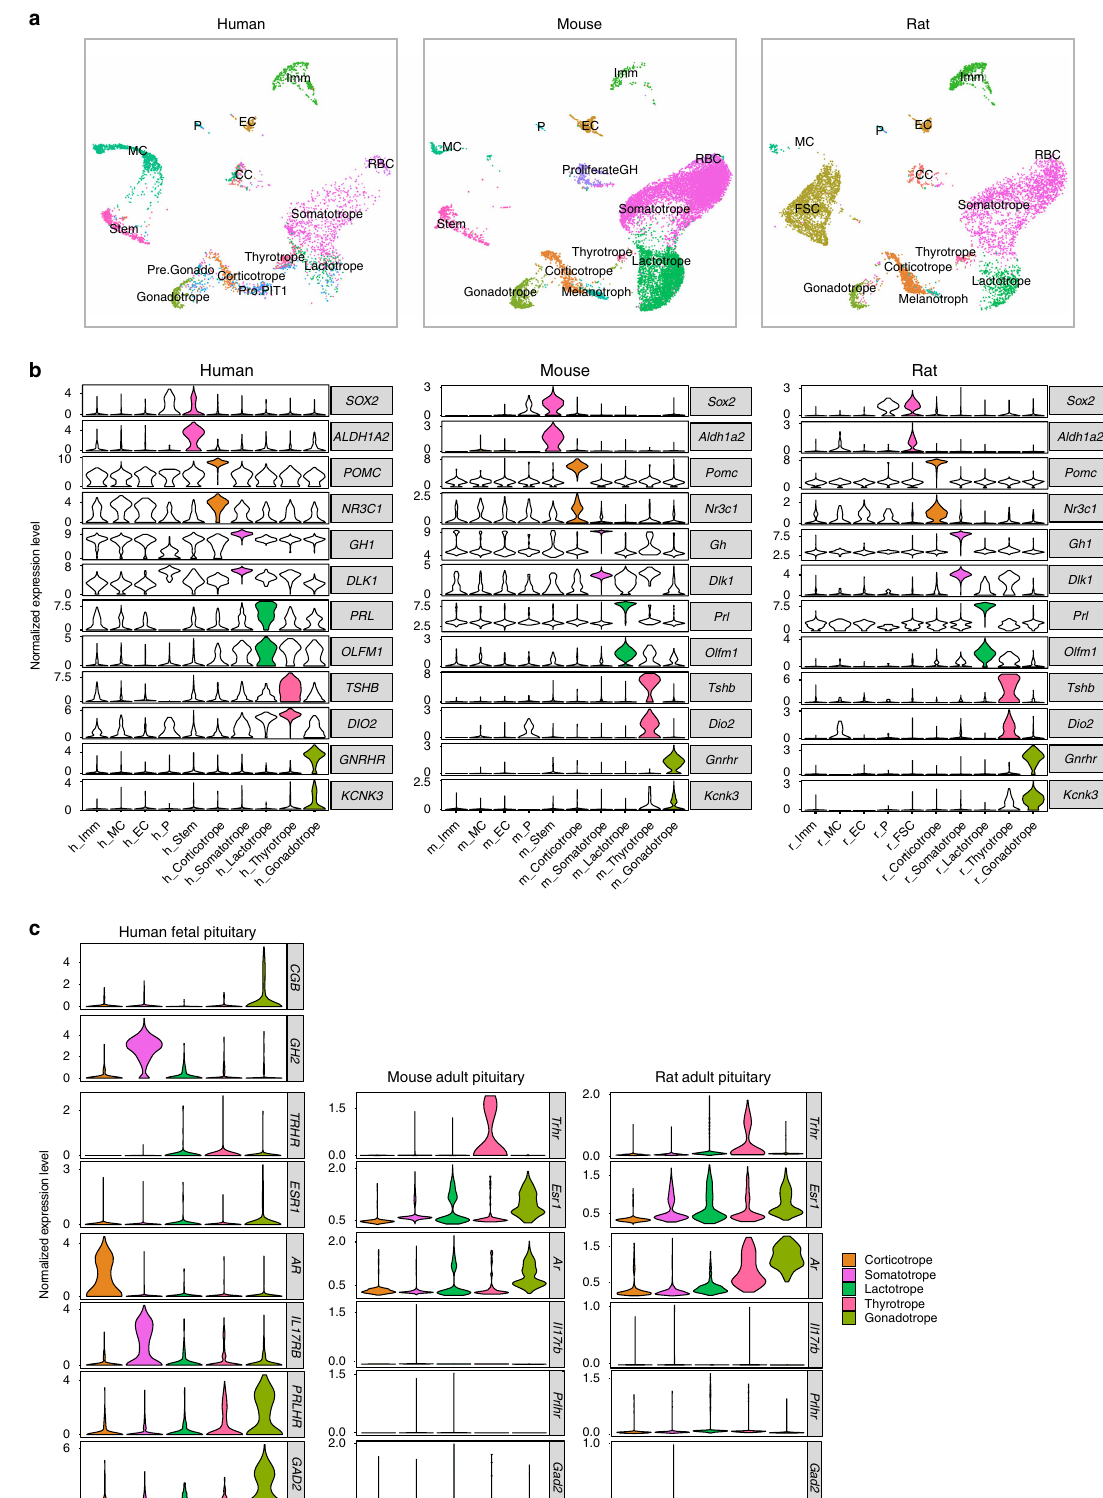
Fig. 8 Comparison among human and rodent pituitaries. a UMAP plots of the pituitary cell types by integrating human and rodent pituitary scRNA-seq data sets, with the cell types identi fi ed in each data set being shown seperatedly. P, pituicytes; MC, mesenchymal cells; EC, endothelial cells; Imm, immune cells; RBC, red blood cells. b Violin plots of the representative identi fi ed markers shared among human, mouse and rat. c Violin plots of the representative distinct cell type-speci fi c genes between the human fetal pituitary and rodent adult